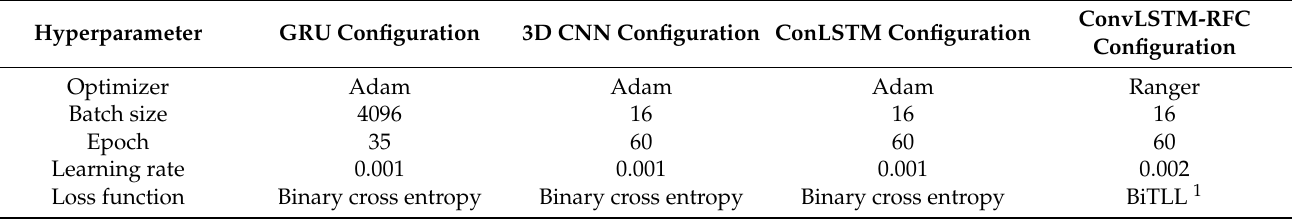
Table 2. Hyperparameter settings of all the models used in the experiment.